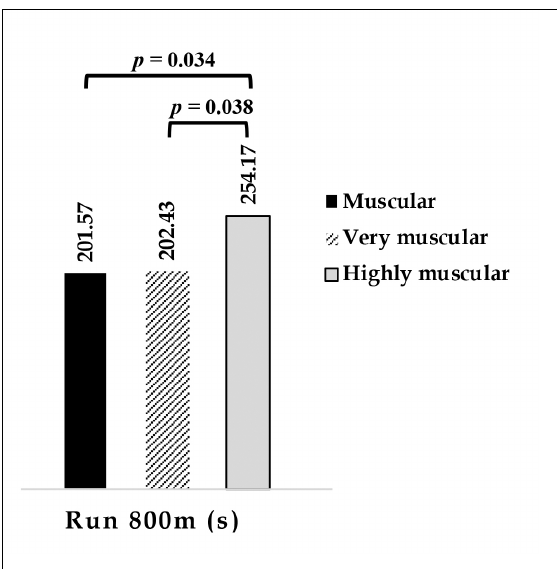
Figure 5. Differences between the BMI groups in time needed to complete the